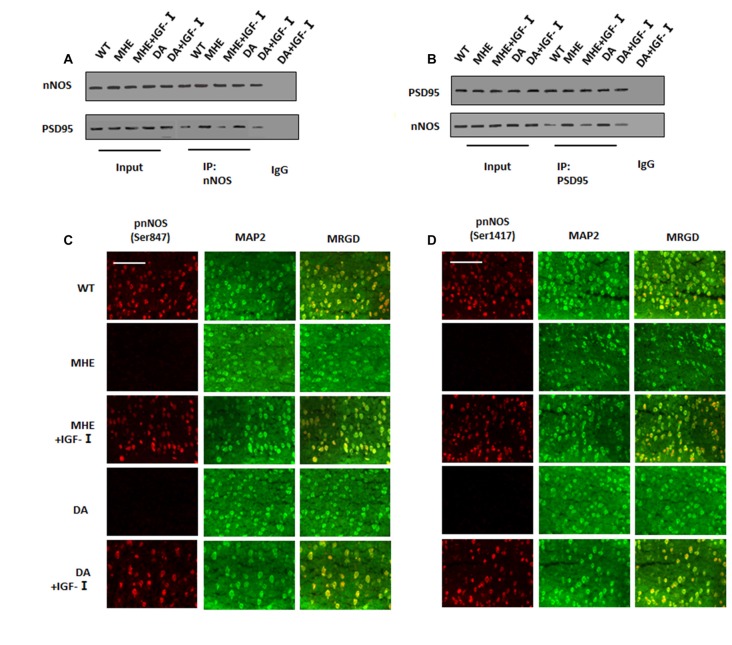
IGF-I disrupts the interaction of PSD95 and nNOS in MHE and DA-treated rats. (A) Immunoprecipitation of lysates of MHE rats (n = 26) or DA-treated rats (n = 20) with or without IGF-I administration using control IgG and anti-nNOS antibodies. Complexes were immunoblotted with anti-PSD95/nNOS antibodies. (B) Immunoprecipitation of lysates of MHE rats or DA-treated rats with or without IGF-I administration using control IgG or anti-PSD95 antibodies. Complexes were immunoblotted with anti-nNOS/PSD95 antibodies. (C) Double IF staining of brain sections from MHE rats and DA-treated rats with or without administration using antibodies against pnNOS Ser847 (red) and MAP2 (green). (D) Double IF staining of brain sections from MHE rats and DA-treated rats with or without IGF-I administration using antibodies against pnNOS Ser1417 (red) and MAP2 (green). Scale bar, 25 μm. MRGD, merged image.